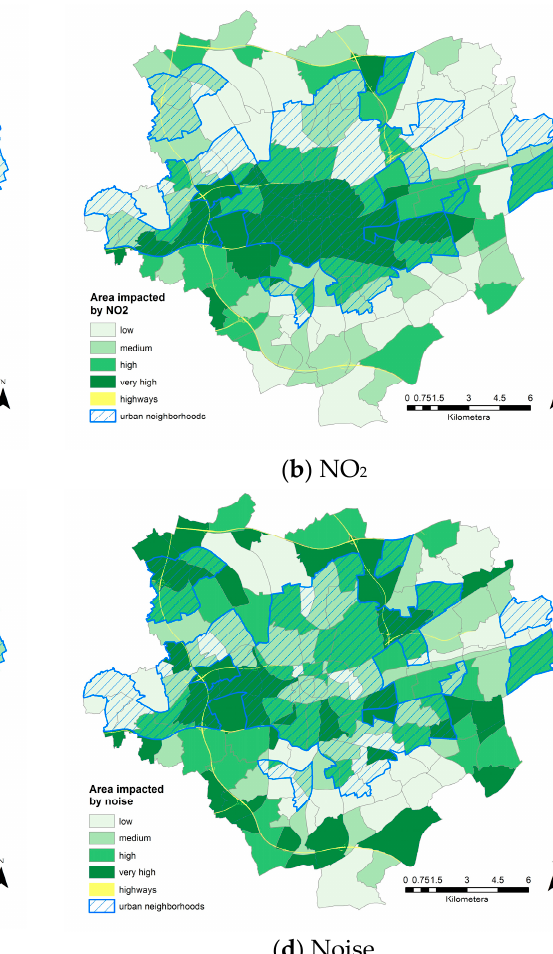
( b ) proportion of area having an annual average NO 2 level ≥ 30 μ g/m³; ( c ) proportion of area having